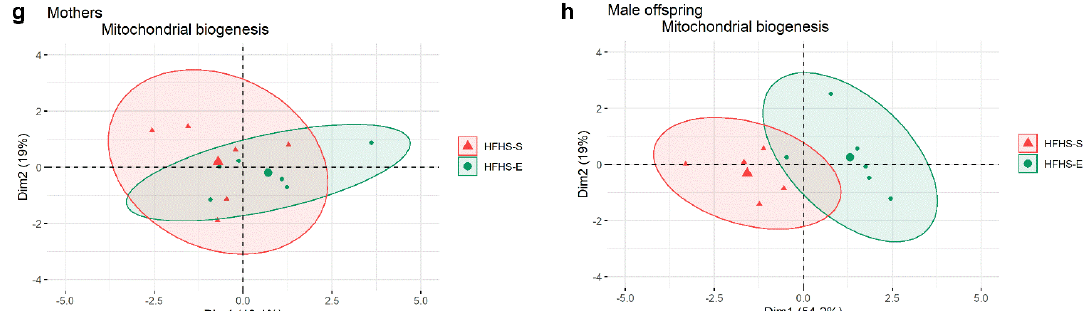
Figure 2. Effects of maternal HFHS and GE on different markers of liver mitochondrial biogenesis in mothers: ( a ) relative content of PGC-1 α , TFAM, and TOM20, ( b ) heat map showing the relative expression levels for Pgc - 1 α and Tfam transcripts, ( c ) mitochondrial DNA copy number, ( g ) principal component analysis of hepatic mitochondrial biogenesis markers; and in offspring: ( d ) relative content of PGC-1 α , TFAM, and TOM20, ( e ) heat map showing the relative mRNA expression levels of Pgc-1 α and Tfam , ( f ) mitochondrial DNA copy number, ( h ) principal component analysis of hepatic mitochondrial biogenesis markers. GE—gestational exercise; C—mothers fed with control